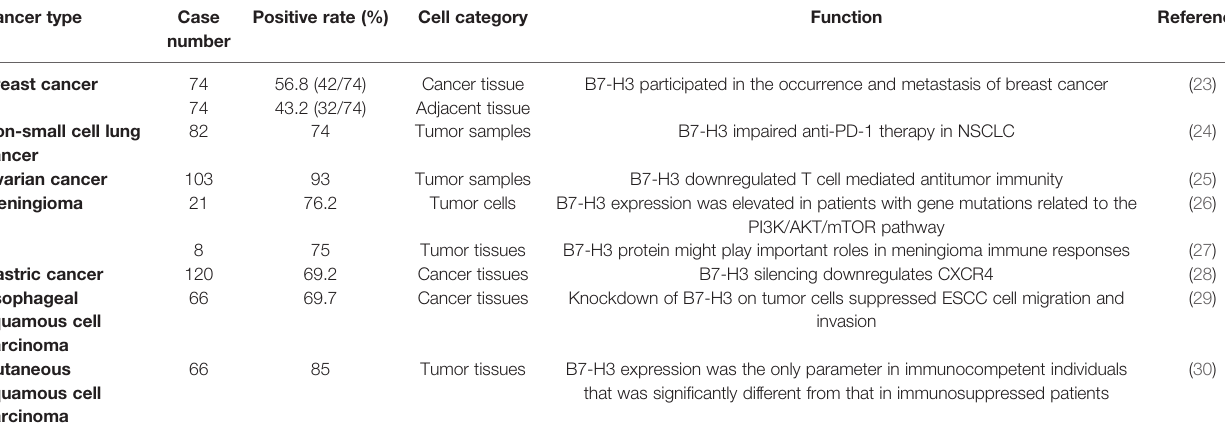
TABLE 1 | Expression and diverse roles of B7-H3 in multiple types of human cancers. Cancer